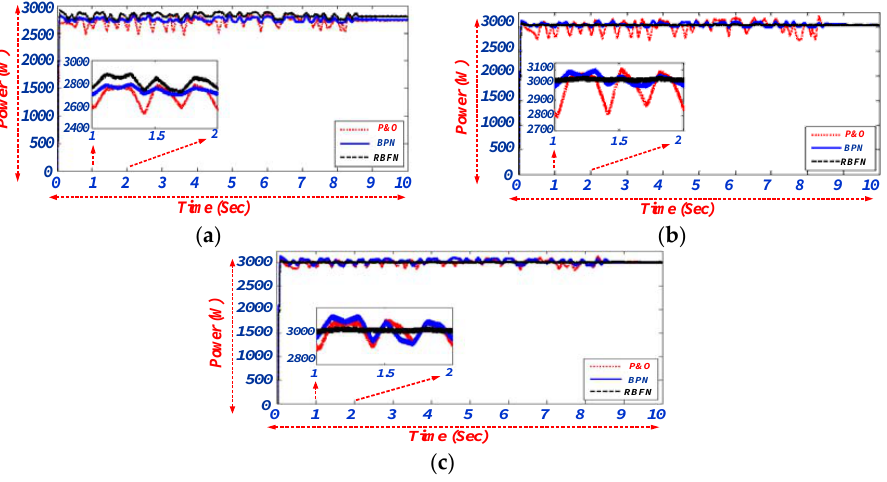
Figure 11. Power output of the WECS for, ( a ) Boost converter; ( b ) SEPIC converter; and ( c ) Quadratic Boost converter with P&O, BPN and RBFN MPPT